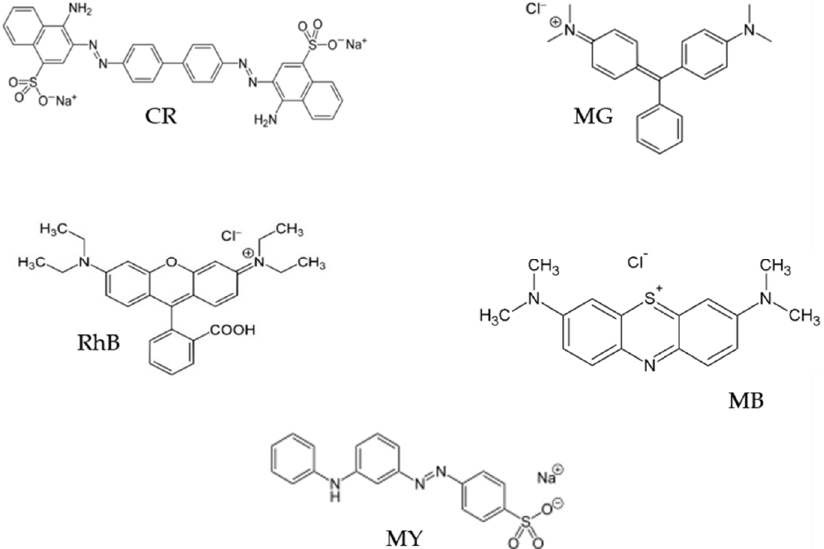
Figure 1. Chemical structure of all of the dyes used in this study such as Congo Red (CR), Malachite Green (MG), Rhodamine B (RhB), Methyl Blue (MB), and Metanil Yellow (MY), respectively.